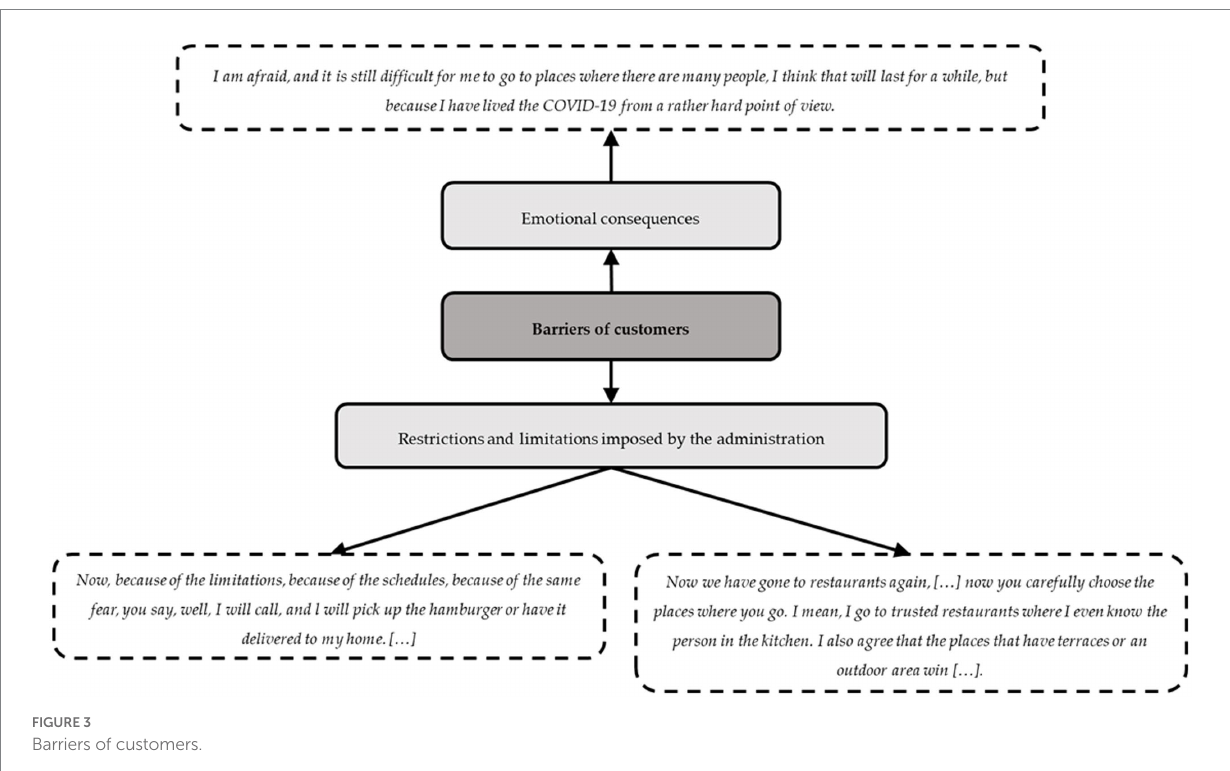
FIGURE 3 Barriers of